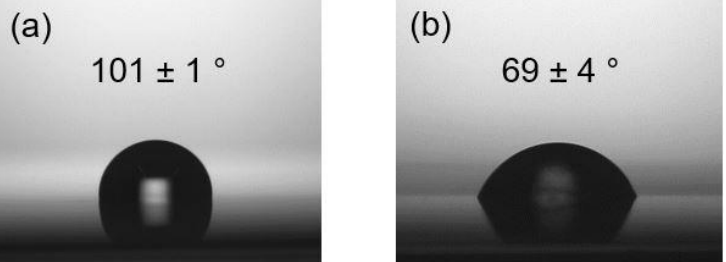
Figure 10. Water droplet images and the surface contact angle measurement: ( a ) non-modified PP; ( b ) PP modified with BHA-DEEA.